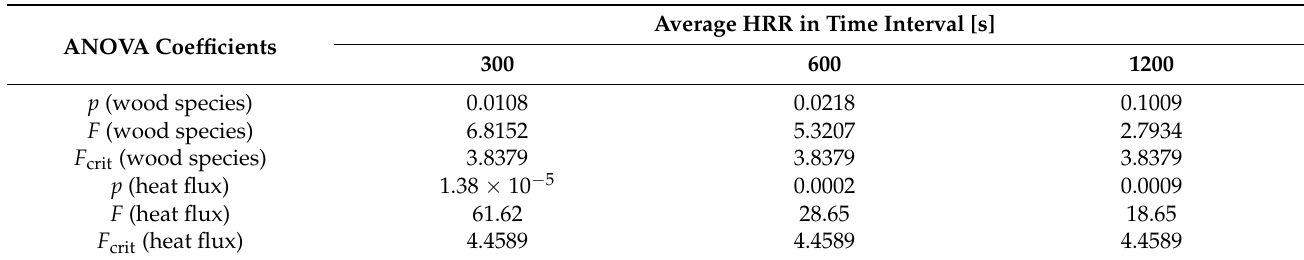
Table 5. Results of two-way ANOVA examining both the impact of wood species and heat flux on the average HRR during investigated time intervals (300, 600 and 1200 s) at a significance level α = 0.05.